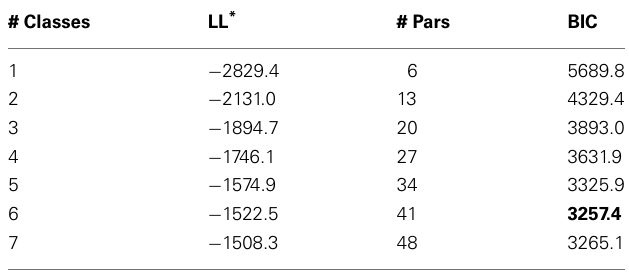
Table 2 | Goodness-of-fit measures for latent class